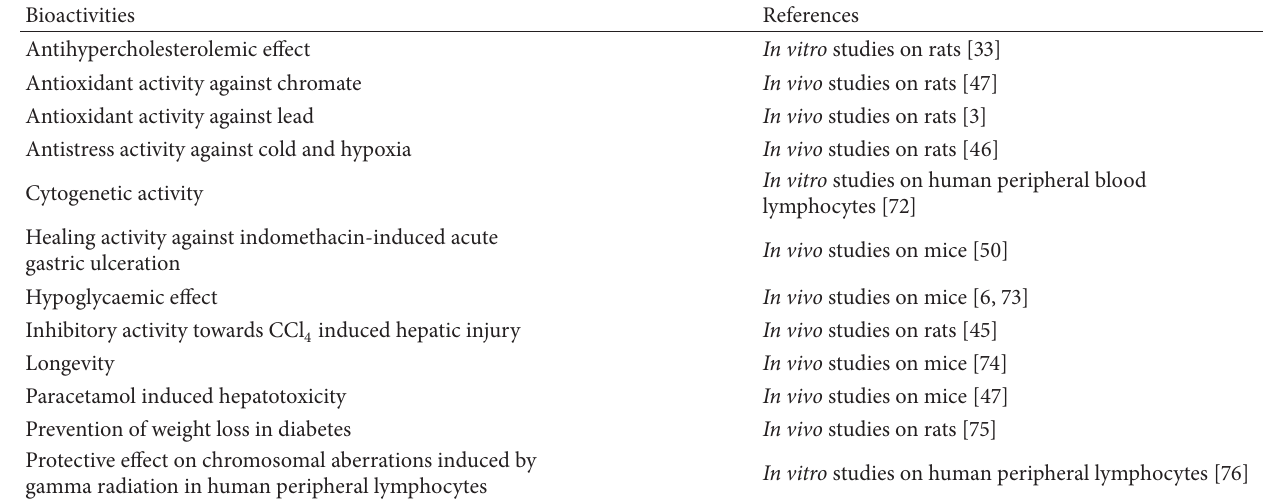
Table 3: Bioactivities of Kombucha and mode of studies which have been carried